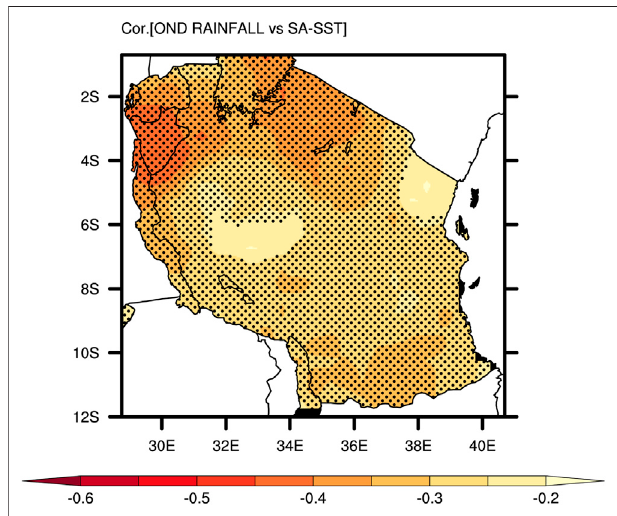
FIGURE 10 | Correlation map of OND rainfall in Tanzania with OND SA- SST index during 1950 – 2017. Regions above the 95% con fi dence level are dotted.